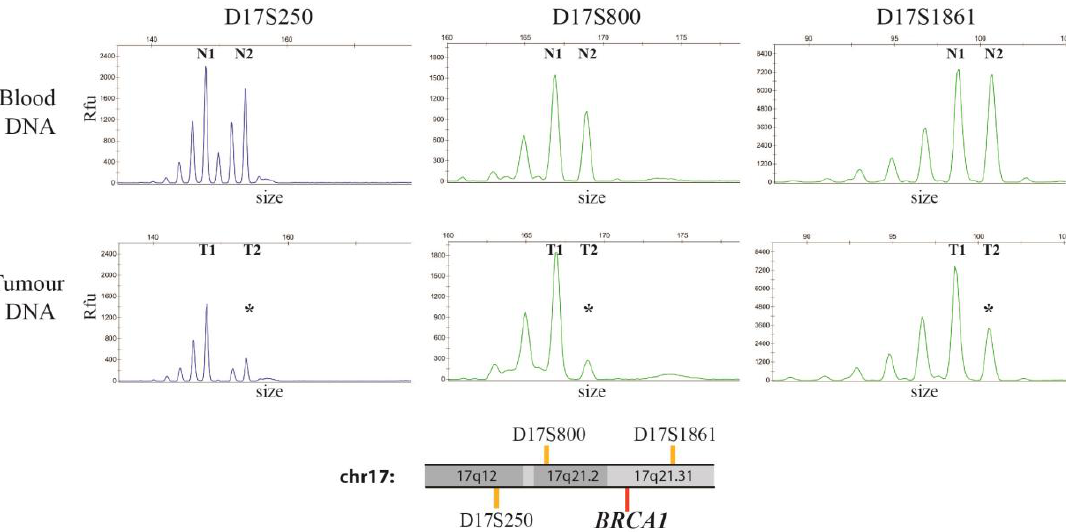
Figure 3. Electropherograms of the three informative STRs in blood and tumor DNA from patient 1; peaks profiles of STRs D17S250, D17S800 and D17S1861 obtained on blood DNA (top panels) and tumor DNA (bottom panels) from Patient 1; x-axis indicates the size in base pairs of each STR while the y-axis refers to the Relative Fluorescence Units (Rfu) of the detected signal, which is directly proportional to the number of copies of each allele. The three STRs had heterozygous results in blood DNA and were thus informative for LOH analysis; the two alleles identified in blood DNA are indicated by N1 and N2 for each STR, while T1 and T2 are the corresponding alleles in tumor DNA. The lost allele for each STR in tumor DNA (T2 for all STRs) is indicated by an asterisk; LOH was confirmed applying the formula on the peak heights described in the methods, which provided values of 0.25, 0.2 and 0.46 respectively (value for LOH <0.50). Genomic location of the three STRs (orange lines) with respect to BRCA1 (17q21.31, red line) are depicted beneath the